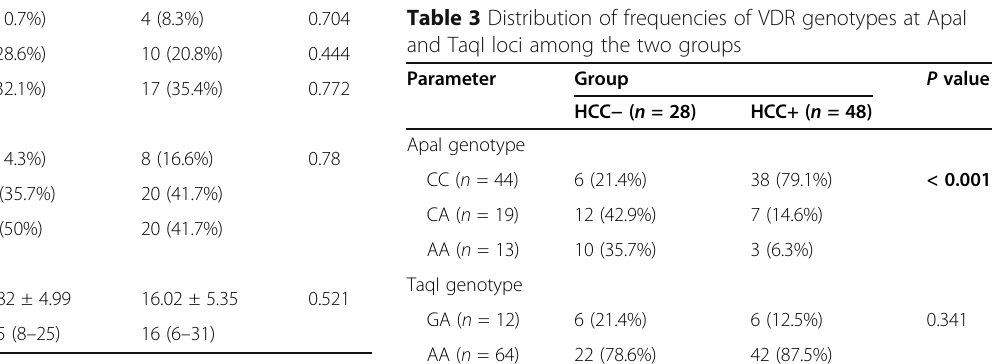
Table 3 Distribution of frequencies of VDR genotypes at